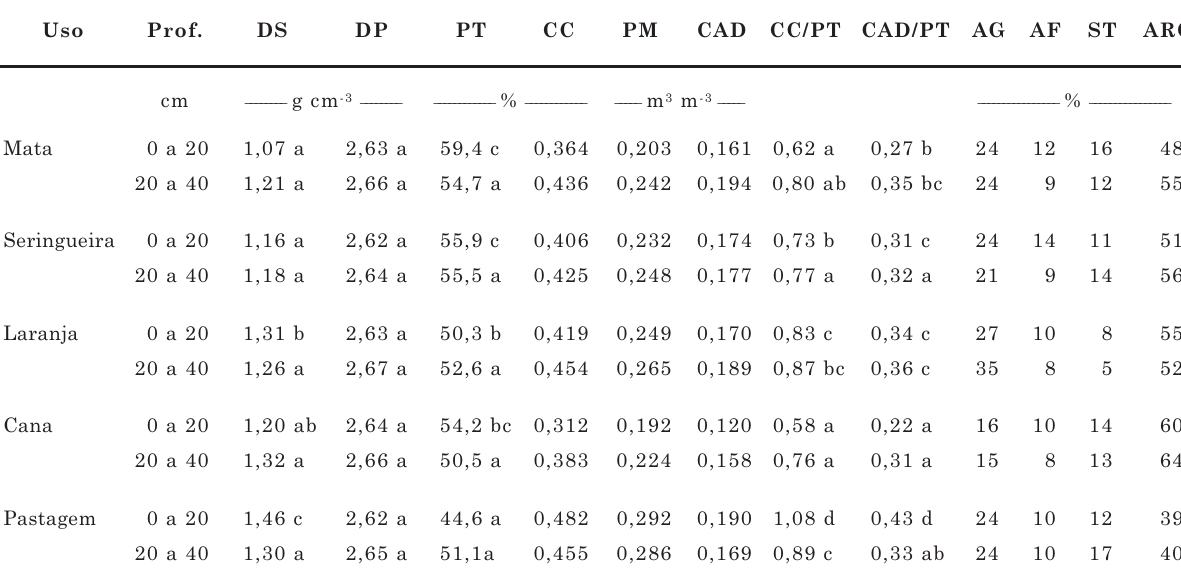
Quadro 3. Densidade do solo (DS) e de partículas (DP), porosidade total (PT), retenção de água na capacidade de campo (CC) e no ponto de murcha permanente (PM), capacidade de adsorção de água (CAD), relações CC/PT e CAD/PT, areia grossa (AG), areia fina (AF), silte (ST) e argila (ARG), para os diferentes usos e